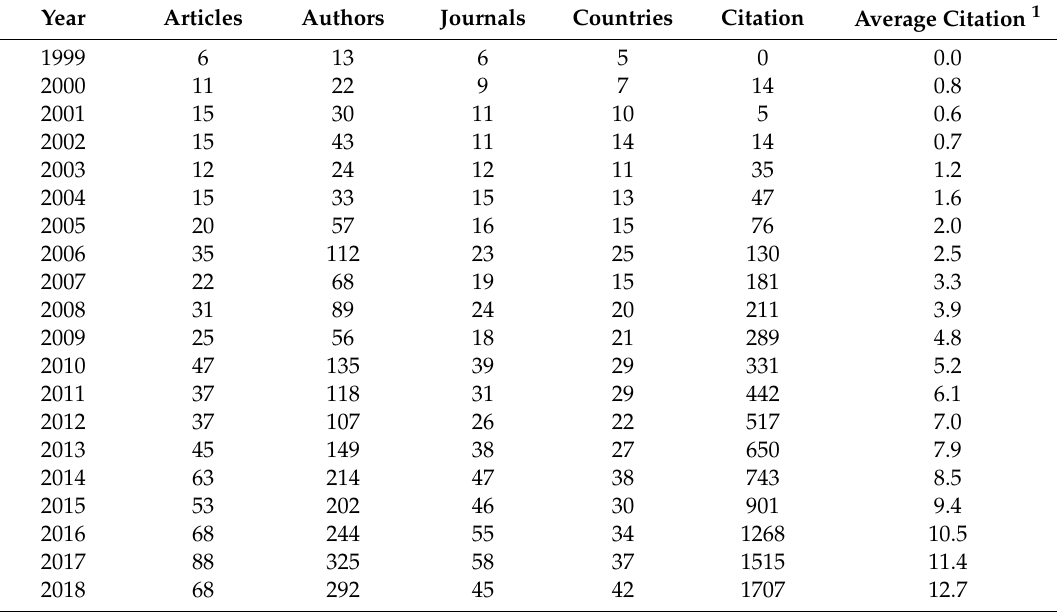
Table 1. Main characteristics of sustainable irrigation (SI) research.